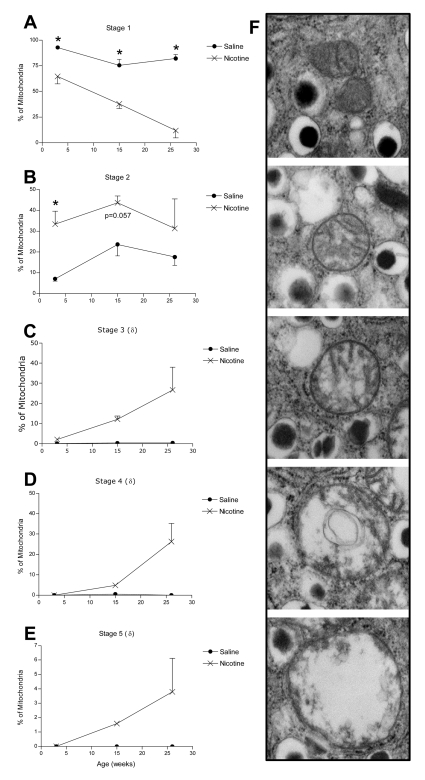
Stages of mitochondrial health during postnatal development.The percentage of mitochondria within beta cells at: A) stage 1, B) stage 2, C) stage 3, D) stage 4, and E) stage 5. F) Electron microscopy images with examples of mitochondria at each of the five morphological stages. δ indicates that statistical analysis was not performed on these data due to lack of variability in the saline treatment group replicates. All data are presented as mean±SEM.